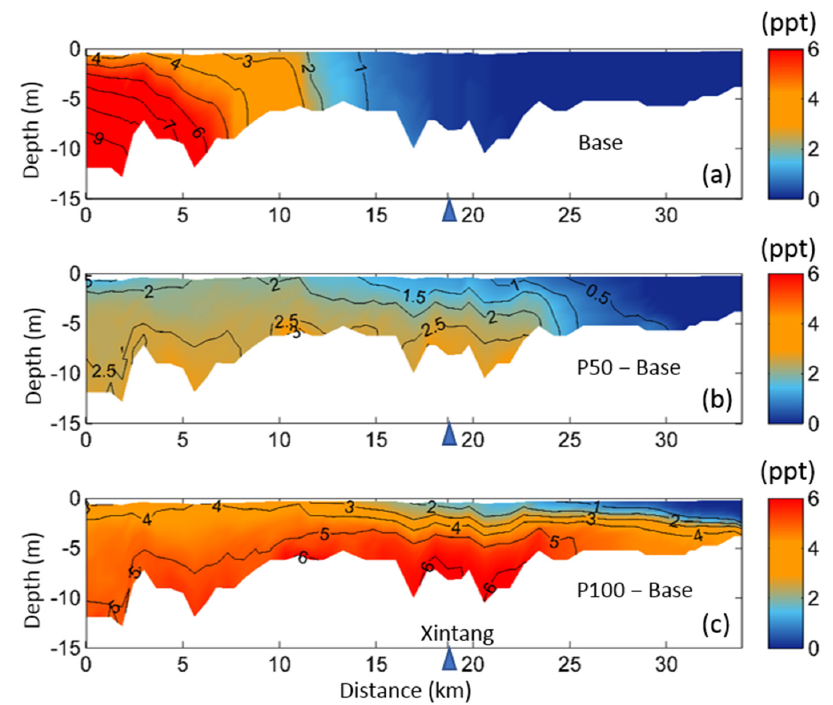
Figure 9. Vertical profiles of salinity (ppt) in the base case ( a ) and salinity increase in each sea-level rise case relative to the base case ( b , c ) along the tributary where Xintang is located. The results are averaged from 6 February 2008, the day after the flow pulse reached a peak. The triangle indicates the location of